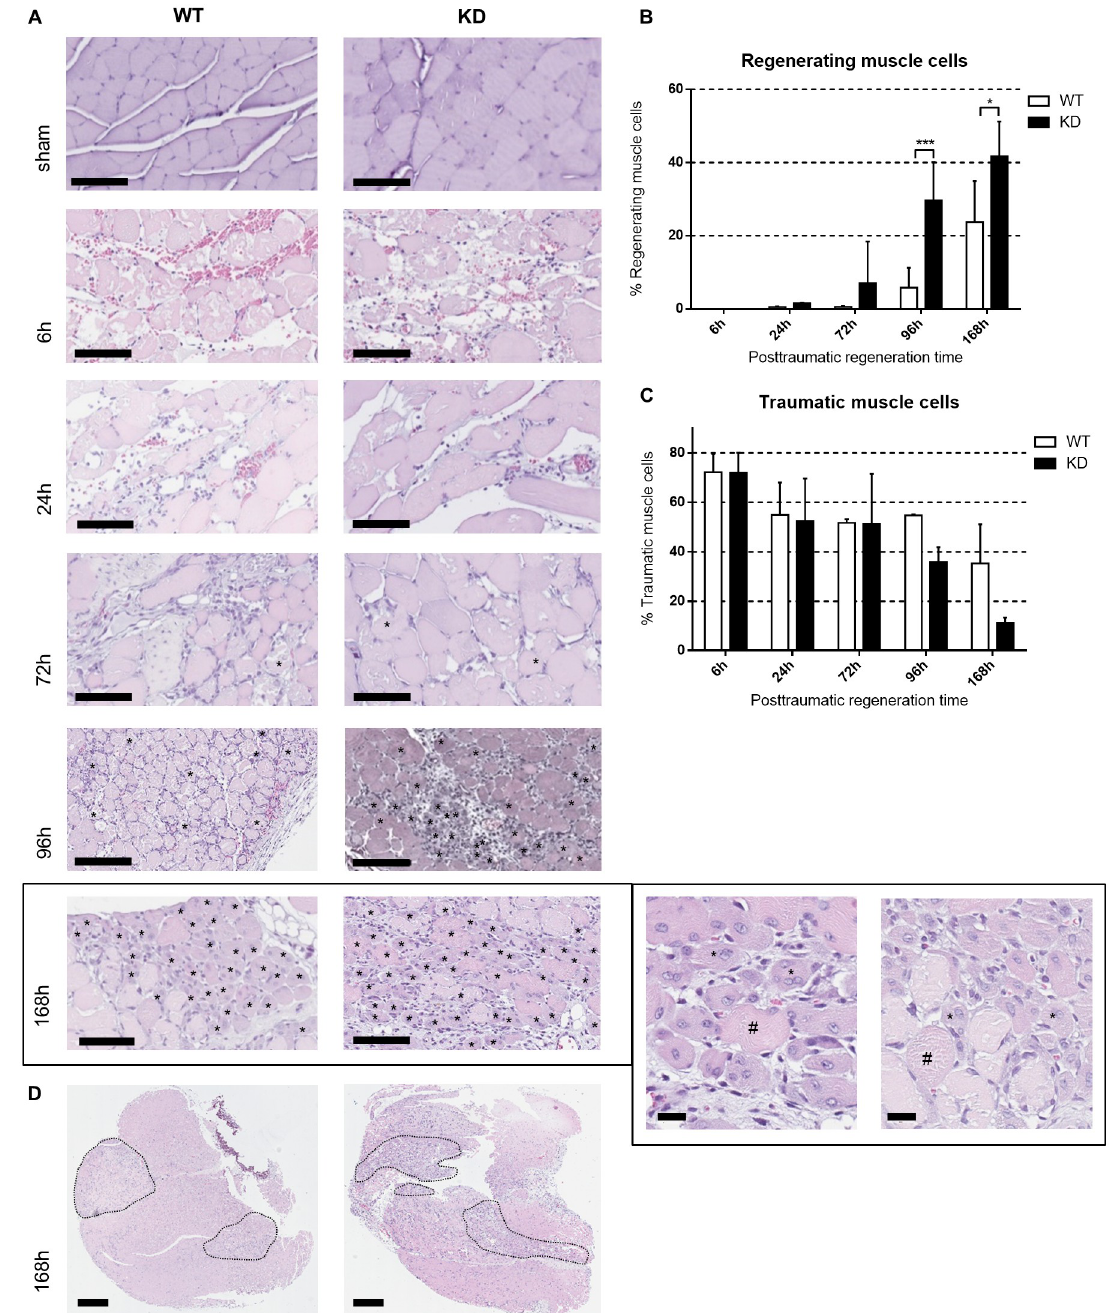
Fig 1. Myotrauma is resolved faster in Phd2 -hypomorphic mice. (A) H&E staining of skeletal muscle at indicated time points after myotrauma (6 h, 24 h, 72 h, 96 h und 168 h) and of sham-treated wild type (WT) and Phd2 -hypomorphic (knockdown, KD) mice. Loss of muscle fiber architecture, haemorrhage and vacuole formation occur early after trauma and are followed by increased immune cell invasion and tissue reorganisation. Regenerating muscle cells are characterised by central nuclei and marked with asterisks ( � ). Shown are slides of 1 μ m thickness (200x magnification; scale bar: 200 μ m). Magnification image of 168h: regenerating ( � ) and non-regenerating (#) muscle cells are displayed exemplarily. Due to the magnification of central trauma areas, genotype differences may not be visible in these images (scale bar: 20 μ m). (B) Relative numbers of regenerating muscle cells (in % of all intact muscle cells) are significantly increased in KD animals compared to WT; n = 4–6. (C) Relative numbers of traumatic muscle cells (in % of all muscle cells) decrease faster in KD mice compared to WT; n = 4–6. � P < 0.05, ��� P < 0.001. (D) Representative images of traumatized muscles in full section. Indicated are traumatic areas. Due to contusion artefacts, areas may appear separated. We observed no difference in acute trauma size between the genotypes indicating a standardized impact procedure. (scale bar: 500 μ